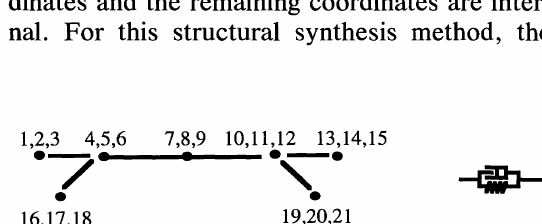
FIGURE 3 Idealized machinery platform model and typical viscoelastic isolator. The isolator schematic represents isolation in each of the three nodal